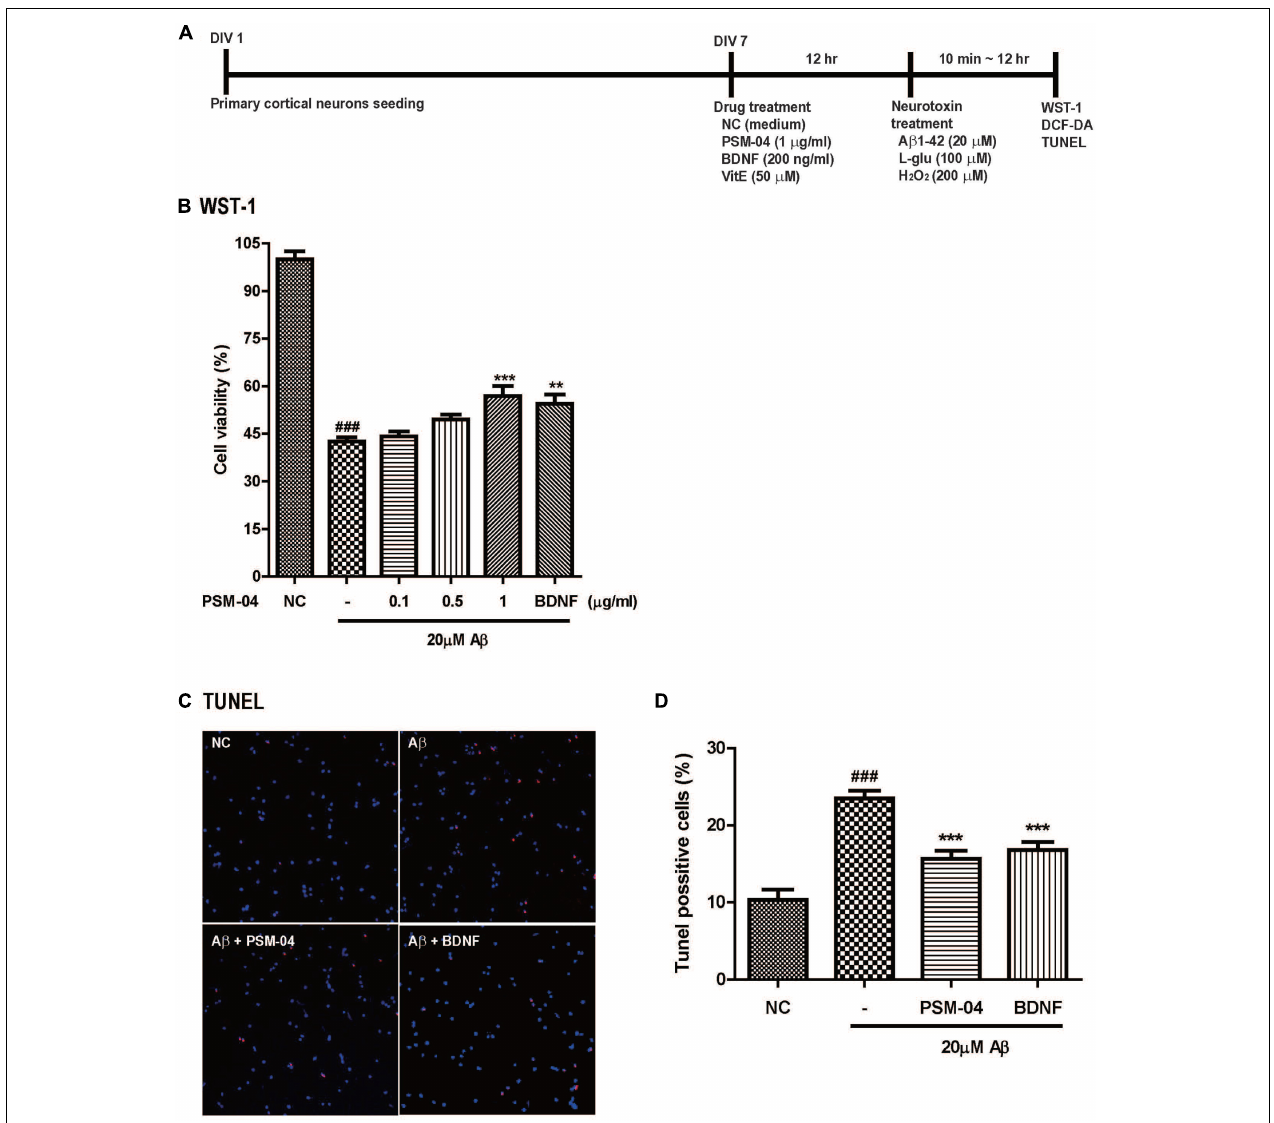
FIGURE 1 | PSM-04 reduced the apoptotic cell death induced by oligomeric A β . (A) A schematic diagram of the in vitro experimental plan is shown. (B–D) Primary cortical neurons were pretreated with PSM-04 (0.1, 0.5, or 1 µ g/mL) for 12 h and then treated with 20 µ M of A β for 12 h. (B) Cell viability was determined by using WST-1 assay. All data are given as means ± standard error of the mean (SEM), and each experiment was repeated five times ( n = 4–6 wells per group, N = 5). (C) The apoptotic cell death in primary cortical neurons was visualized by TUNEL staining (red) and counterstaining with DAPI (blue); consequently, 1- µ g/mL PSM-04 or 200-ng/mL BDNF reduced the apoptotic cell death induced by 20 µ M of A β . (D) The population of TUNEL-positive cells (red) is shown as a percentage compared to the total cell number. All data are given as means ± SEM and each experiment was repeated five times ( n = 3 wells per group, N = 5). The statistical analyses were performed by one-way ANOVA followed by the Newman–Keuls post hoc test ### p < 0.001 vs. control (NC). ∗ p < 0.05, ∗∗ p < 0.01, and ∗∗∗ p < 0.001 vs. A β